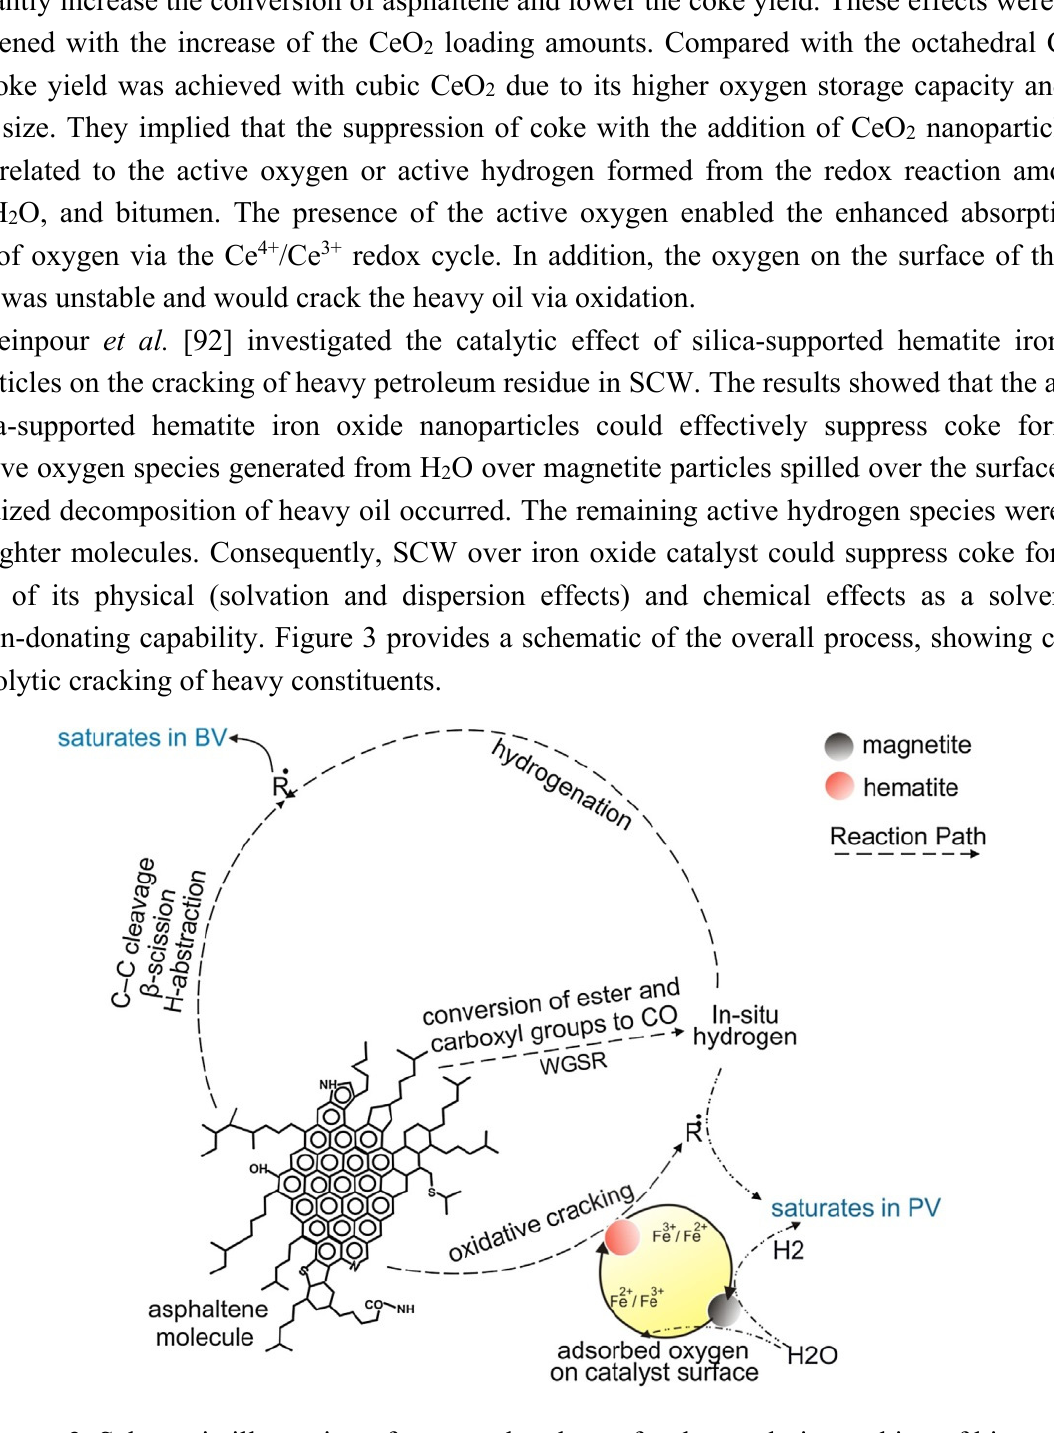
Figure 3. Schematic illustration of proposed pathway for the catalytic cracking of bitumen in SCW. Reproduced with permission from [92], published by Elsevier Limited,